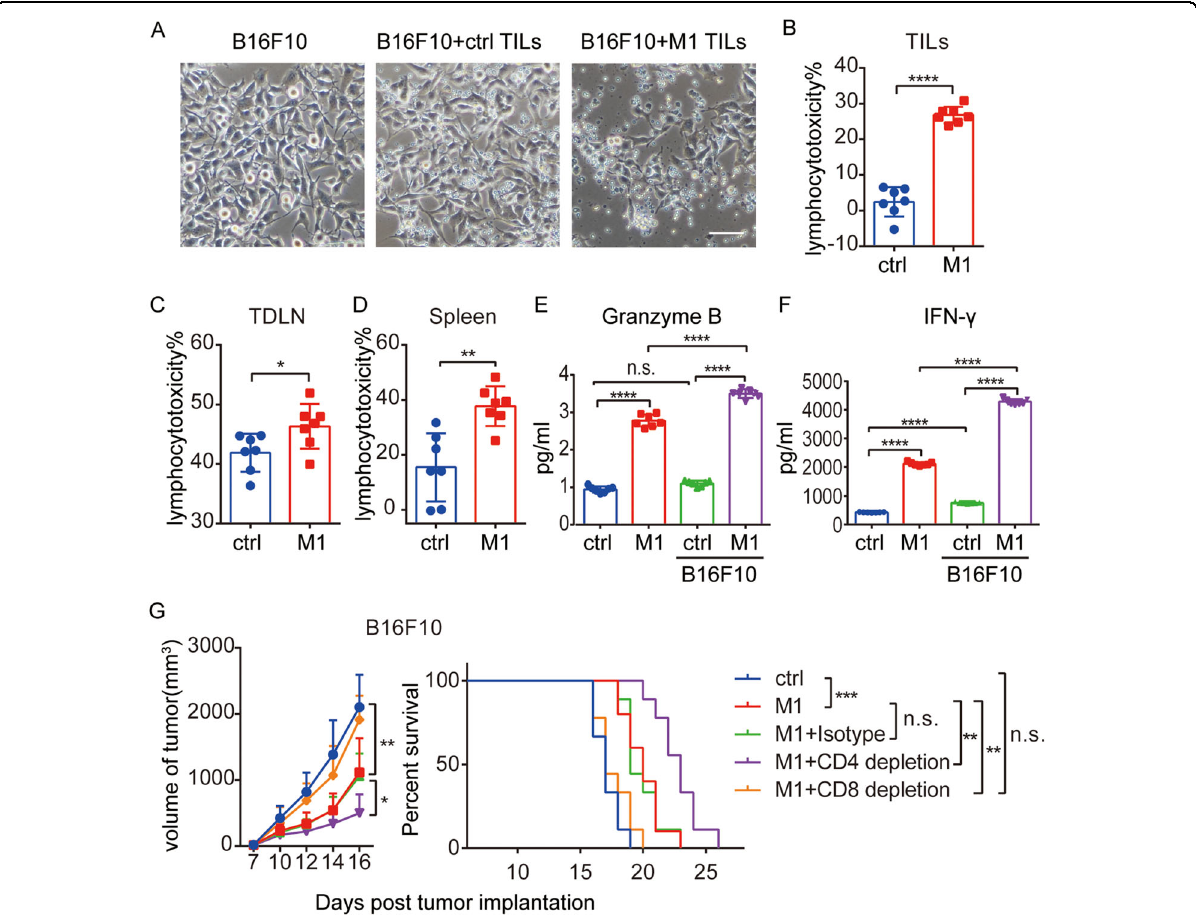
Fig. 5 The M1 virus induces local and systemic CD8 + T cell-dependent antitumor immunity. A Tumor-in fi ltrating lymphocytes (TILs) were isolated from B16F10 tumor tissue samples and cocultured with the B16F10 cell line for 48 h; phase-contrast images are shown. The images are representative of six biological repetitions. Scale bars: 50 μ m. B – D Lymphocytes isolated from B16F10 tumor tissue samples (TILs), tumor-draining lymph nodes (TDLN), and the spleen were cocultured with B16F10 cells for 48 h to evaluate lymphocytotoxicity. n = 7. The P value was determined by a two-tailed Student ’ s t test. E , F Granzyme B ( E ) and IFN- γ ( F ) were analyzed in supernatants of splenic lymphocytes cocultured with or without B16F10 cells. n = 6. The P value was determined by one-way ANOVA with Dunnett ’ s test. G C57BL/6 mice were implanted subcutaneously in the right fl ank with B16F10 cells on day 0 and treated intravenously with ctrl ( n = 6) or M1 ( n = 6) (1 × 10 7 pfu) once per day on days 6 – 10. An anti-CD4 depletion antibody, anti-CD8 depletion antibody, or isotype control antibody was injected intraperitoneally on days 4, 7, 10, and 13. B16F10 tumor growth (left) and Kaplan – Meier survival (right) curves for the mice in each group are shown. ctrl, n = 9; M1, n = 10; M1 + isotype, n = 9; M1 + CD4 depletion, n = 9; M1 + CD8 depletion, n = 9. P values were determined by one-way ANOVA of the fi nal time point as indicated in the graphs and by the log-rank test. Data are shown as the mean ± SD. n.s., not signi fi cant; * P < 0.05; ** P < 0.01; *** P < 0.001. **** P < 0.0001. See also Supplementary Figs. S5 and